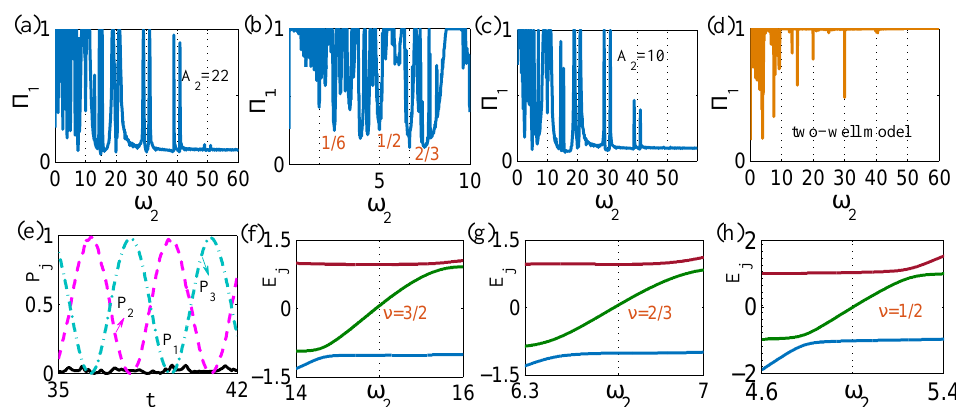
Figure 5. (Color online) Plots in the first row represent evolutions of Π 1 as a function of ω 2 for the driven three well system in ( a – c ) and the driven two well system in ( d ). ( e ) Evolution of the probability P j at three wells when photon-assisted tunneing occurs. Plots ( f – h ) are the quasienergies E j versus ω 2 at different fractional resonances which respectively are ν = 3/2, 2/3 and 1/2. The parameter A 2 = 10 in ( c ) and A 2 = 22 in other plots. Other parameters are chosen as ω 1 = 10, A 1 = 22, g = 1, φ = 0 and time t is within 100 time